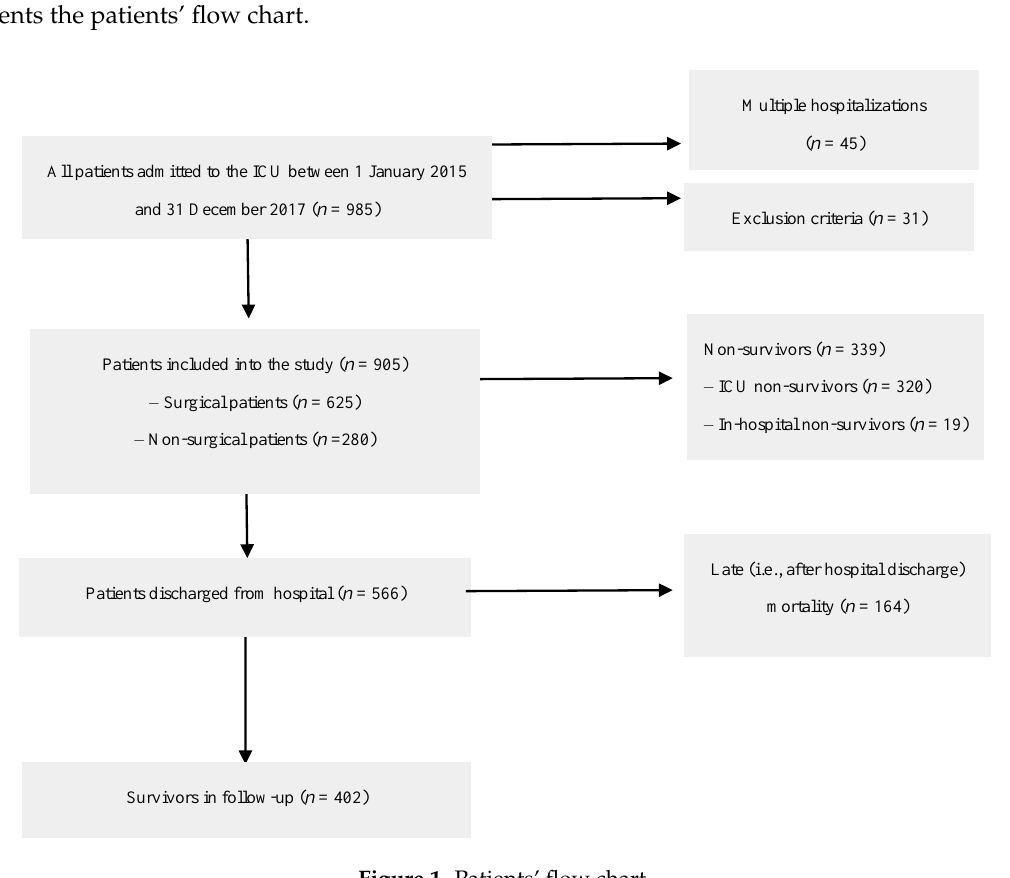
Figure 1. Patients’ flow chart.